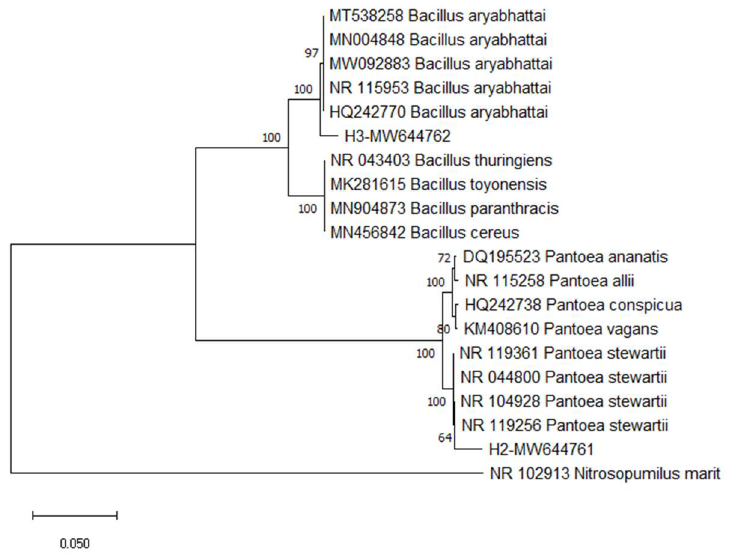
their reference Figure 1. The neighbor-joining tree represents the phylogenetic placement of strains H2 and H3 with their reference strains.